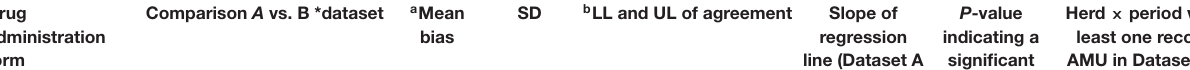
TABLE 2 | Slope of the regression line comparing antimicrobial use (AMU) DCD vet /animal/year metric of three datasets, and bias, variability of the bias, and limits of agreement for AMU across three datasets in a sample of 60 Swedish dairy herds (30 conventional and 30 organic). Drug